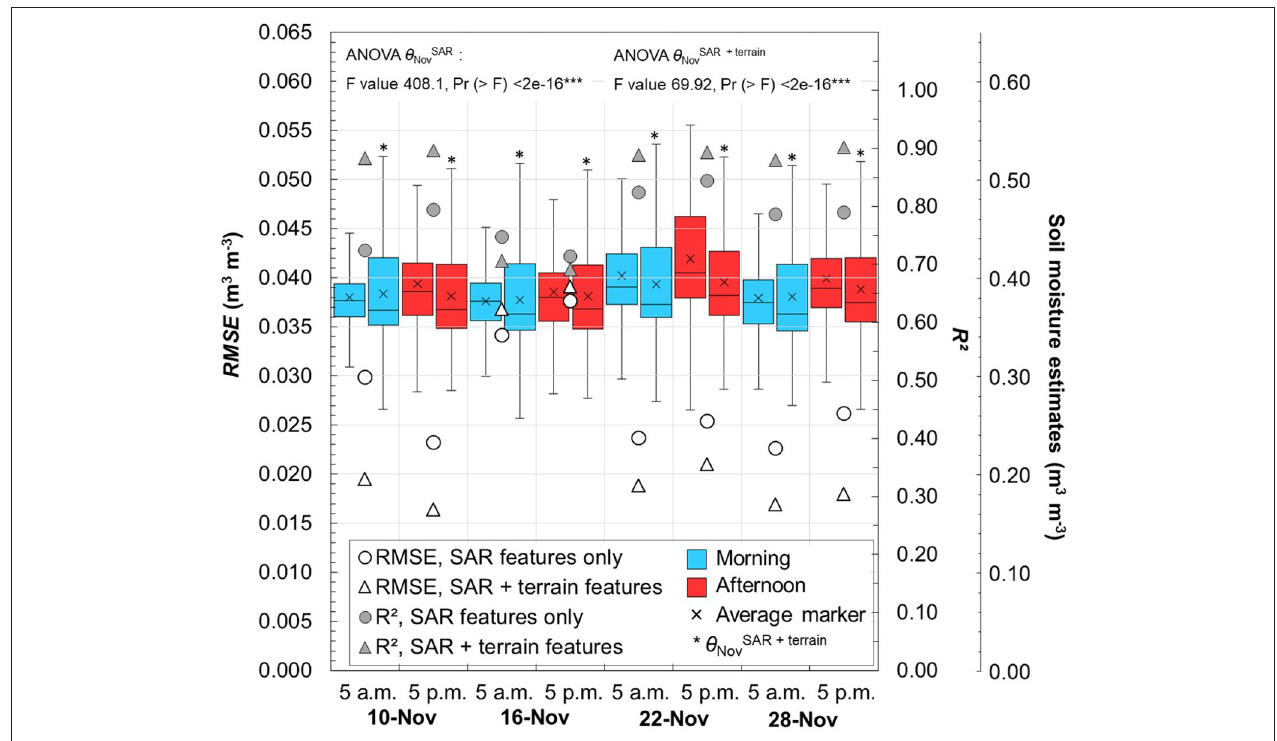
FIGURE 3 | Estimation performance indicators R ² (right y axis) and RMSE (left y axis) for the models θ NovSAR and θ NovSAR + Terrain to approximate the in-situ soil moisture ( θ ) at the eight Sentinel-1 overpasses in Nov. 2018. The box plots show the distributions of the predicted spatial estimates (second y axis at the right) of θ in the morning (blue color) and in the afternoon (red color) for θ NovSAR and θ NovSAR + Terrain (indicated by